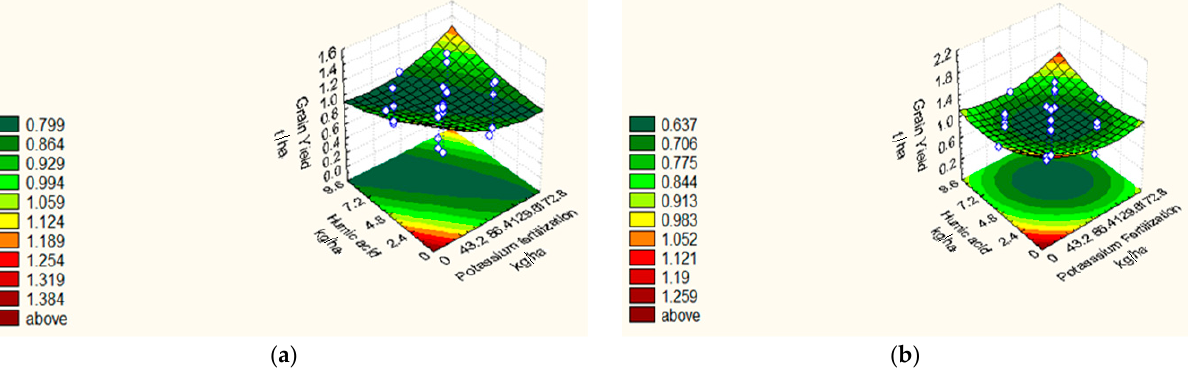
Figure 8. Response surface for grain yield as affected by PF and HA at the central levels of AA, and AC in ( a ) 2018/19 and ( b ) 2019/20.